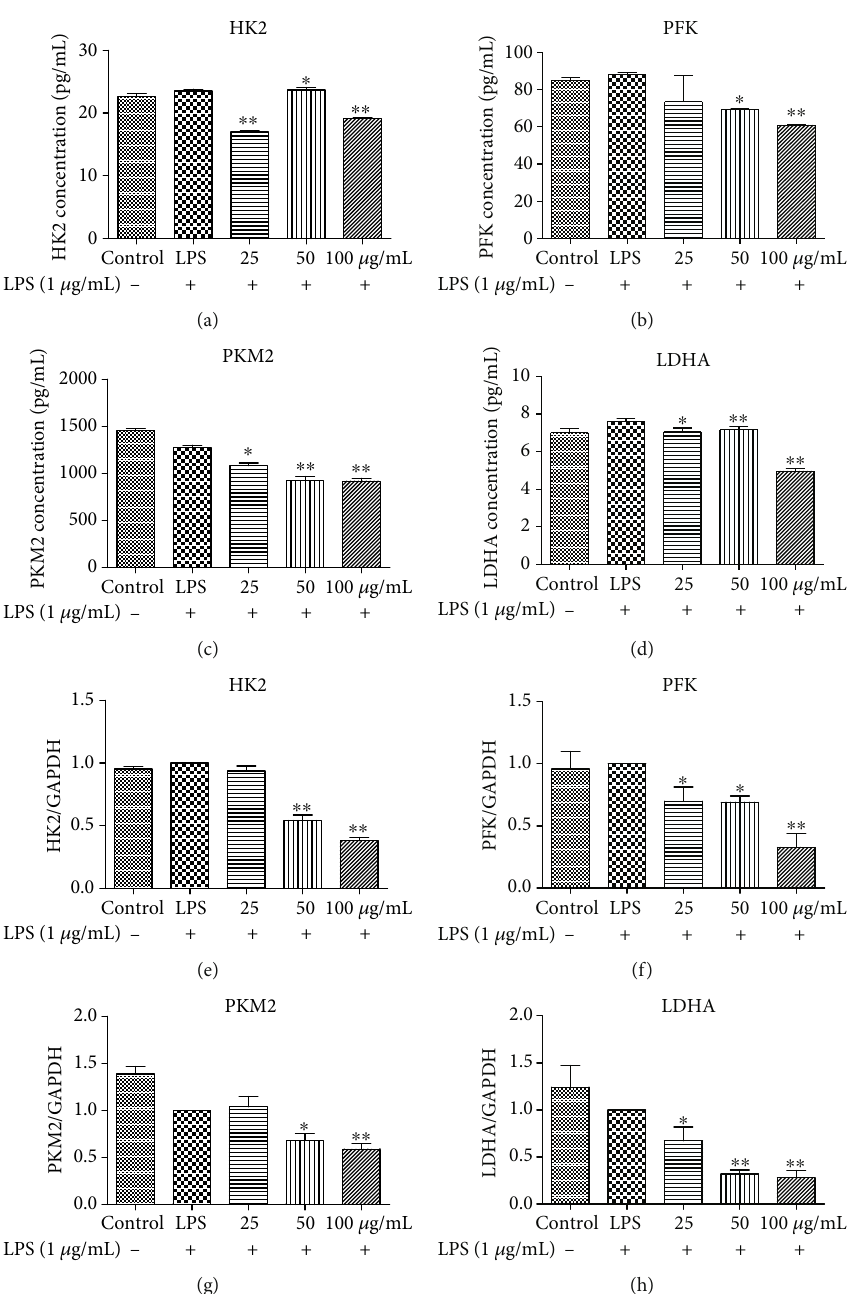
Figure 4: EECP decreased the levels of HK2, PFK, PKM2, and LDHA in MDA-MB-231 cells stimulated with LPS. (a) – (d) EECP decreased the levels of HK2, PFK, PKM2, and LDHA in MDA-MB-231 cells, as detected by ELISA kits. (e) – (h) EECP decreased the levels of HK2, PFK, PKM2, and LDHA in MDA-MB-231 cells, as detected by RT-PCR. Values represent the mean ± SEM from three independent experiments ( ∗ P < 0 : 05 , ∗∗ P < 0 : 01 vs. control, n = 3